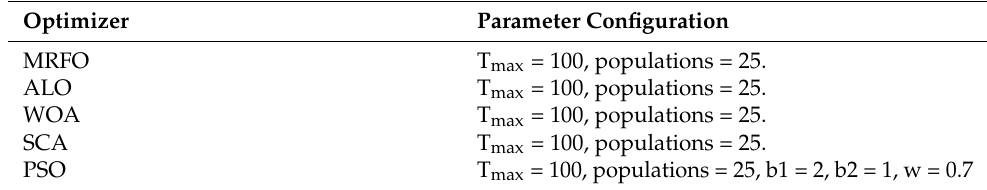
Table 3. Parameters used in each optimization technique.